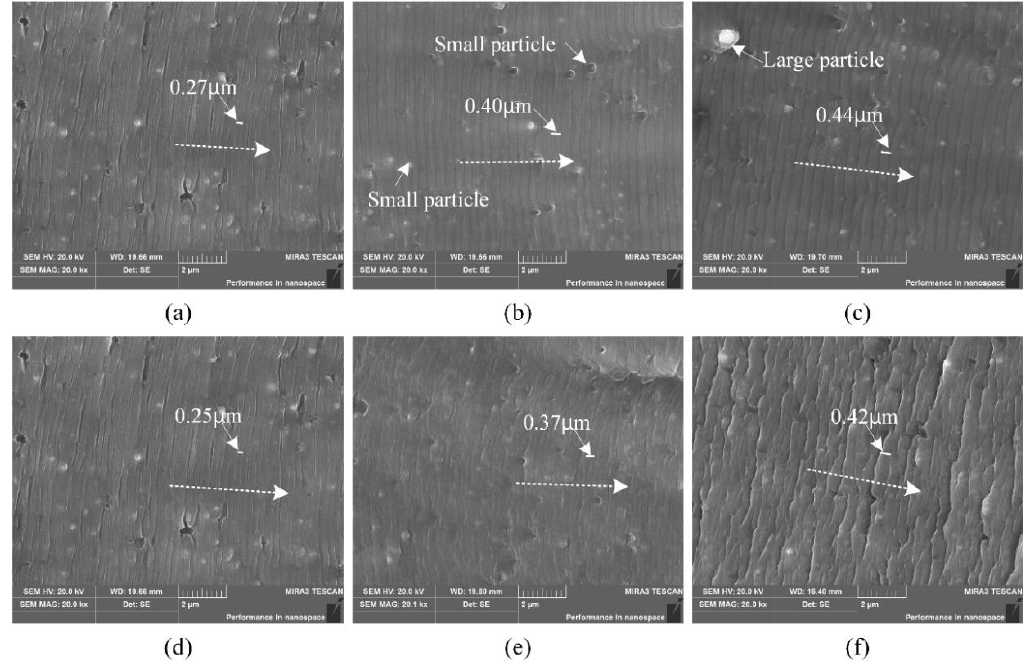
Figure 11. Fatigue striation morphology at fractures of different specimens when ∆ K = 6 MPa · m 1/2 : ( a ) CAF-4h; ( b ) CAF-9h; ( c ) CAF-24h; ( d ) SFA-4h; ( e ) SFA-9h; ( f ) SFA-24h.